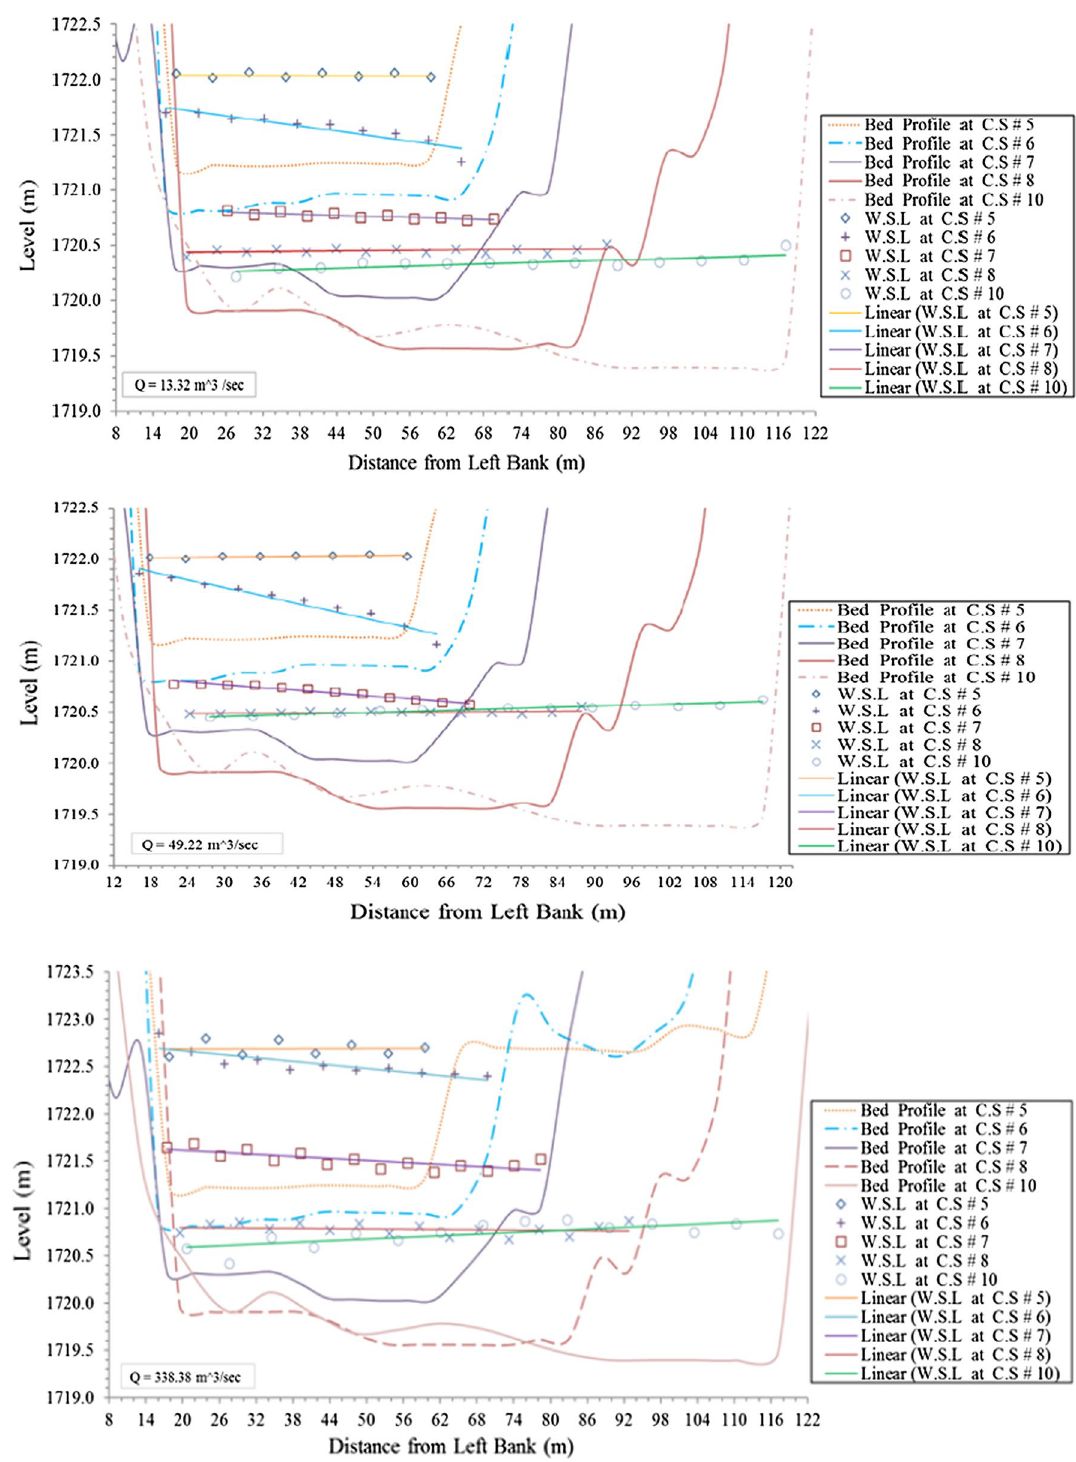
Fig. 11 Cross-profiles of water surface in the meander